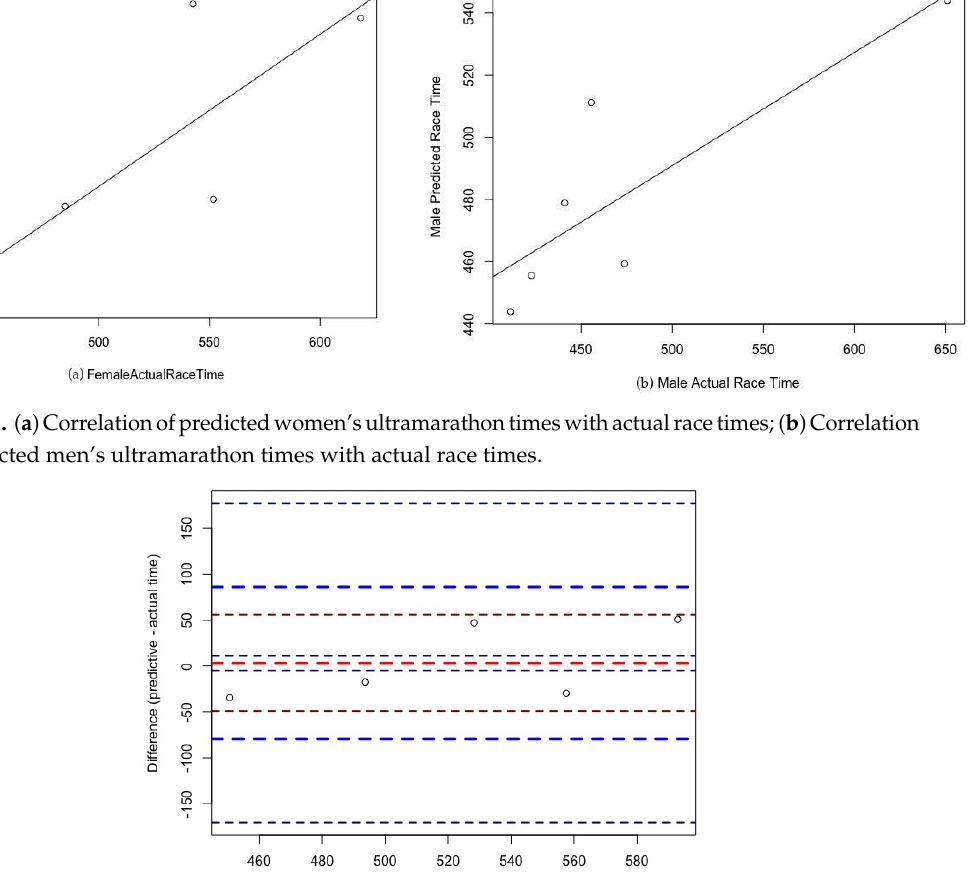
Figure 2. Bland – Altman plots comparing predicted and effective race times for women .